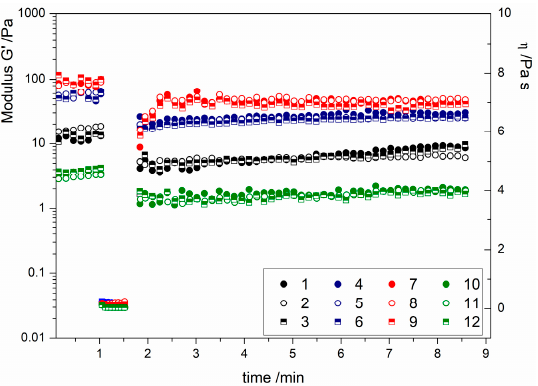
Figure 5. Three-step thixotropy test of hydrogels produced with low Ca 2+ content (black symbols), medium Ca 2+ content (blue symbols), high Ca 2+ content (red symbols), and low alginate and medium* Ca 2+ content (green symbols). For detailed sample compositions, see Table 1.